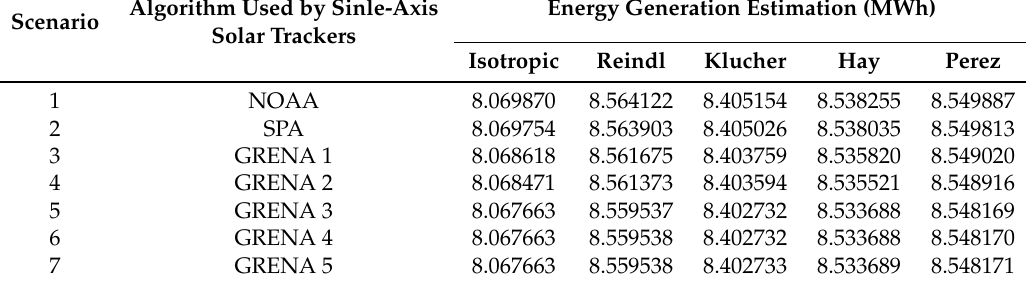
Table 4. Result of energy generation estimation using different algorithms for Sun tracking in Cape Town, South